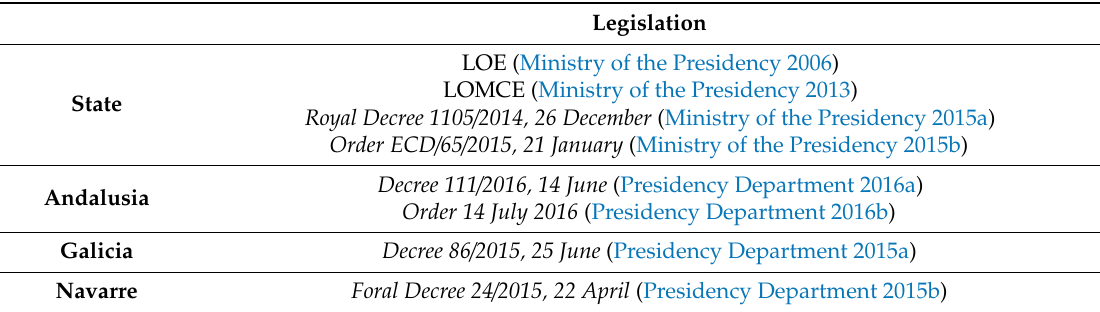
Table 1. Legal regulations analyzed 1 .